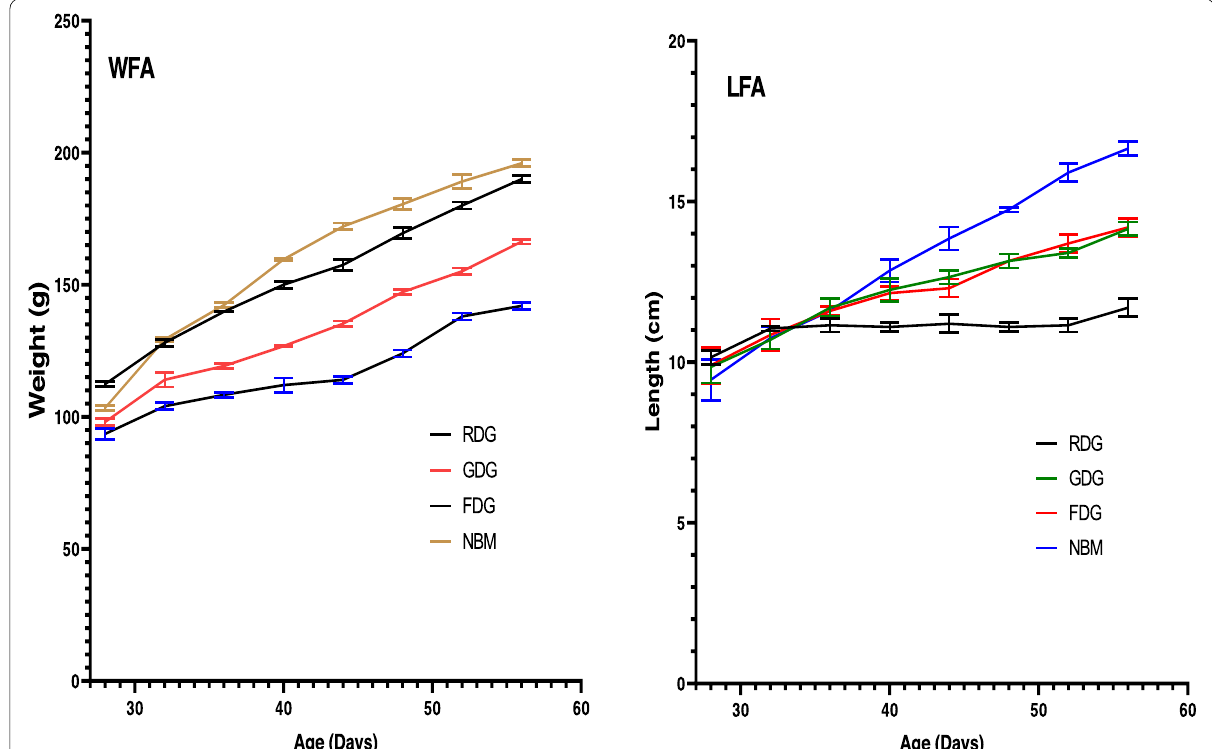
Fig. 1 Weight-for-age (WFA, underweight) and Length-for-age (LFA, stunting) of Wistar rats fed on complementary diets. RDG- Raw maize, defatted groundnut and ginger in ratio 76.7:20.8:2.5. GDG- Germinated maize, defatted groundnut and ginger in ratio 74.4:23.1:2.5. FDG- Fermented maize, defatted groundnut and ginger in ratio 72.6:24.9:2.5. NBM- Nutribom (a commercial maize-based complementary